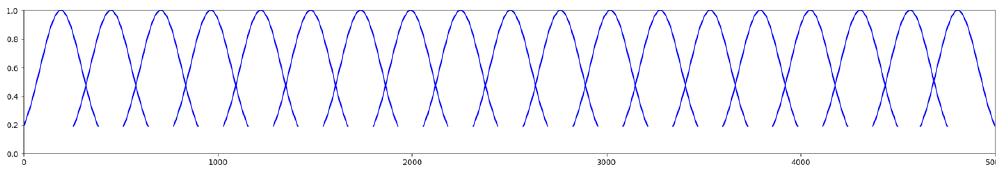
Figure 4. The Gaussian kernel used for weighting segmentation model predictions.